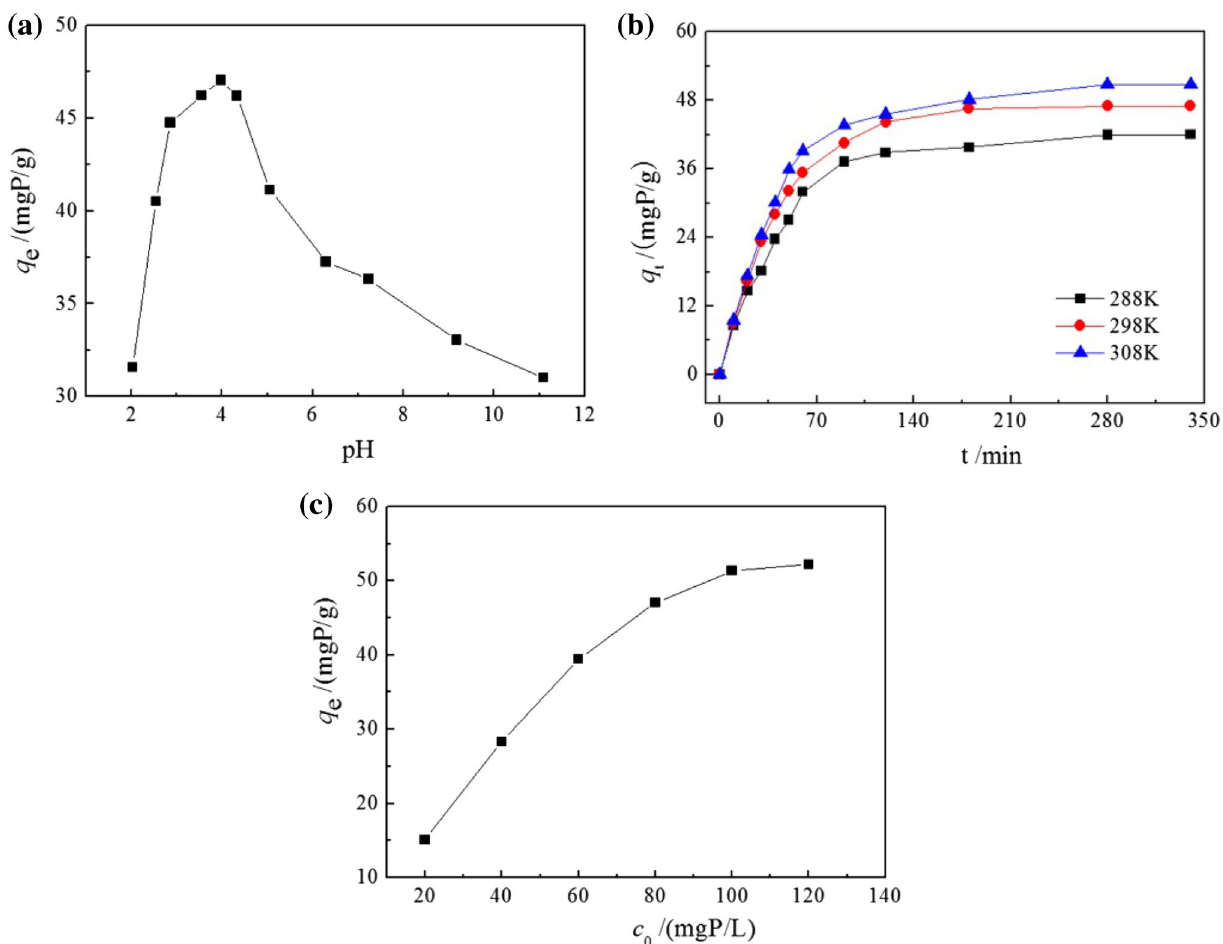
Fig. 3 Effects of pH, temperature, contact time, and initial phosphate concentration on phosphate adsorption by the DETA-PES affinity membrane: a pH [c 0 (phosphate) = 80 mg P/L; t : 360 min; mem- brane dry weight: 0.1 g; T : 298 K]; b temperature and contact